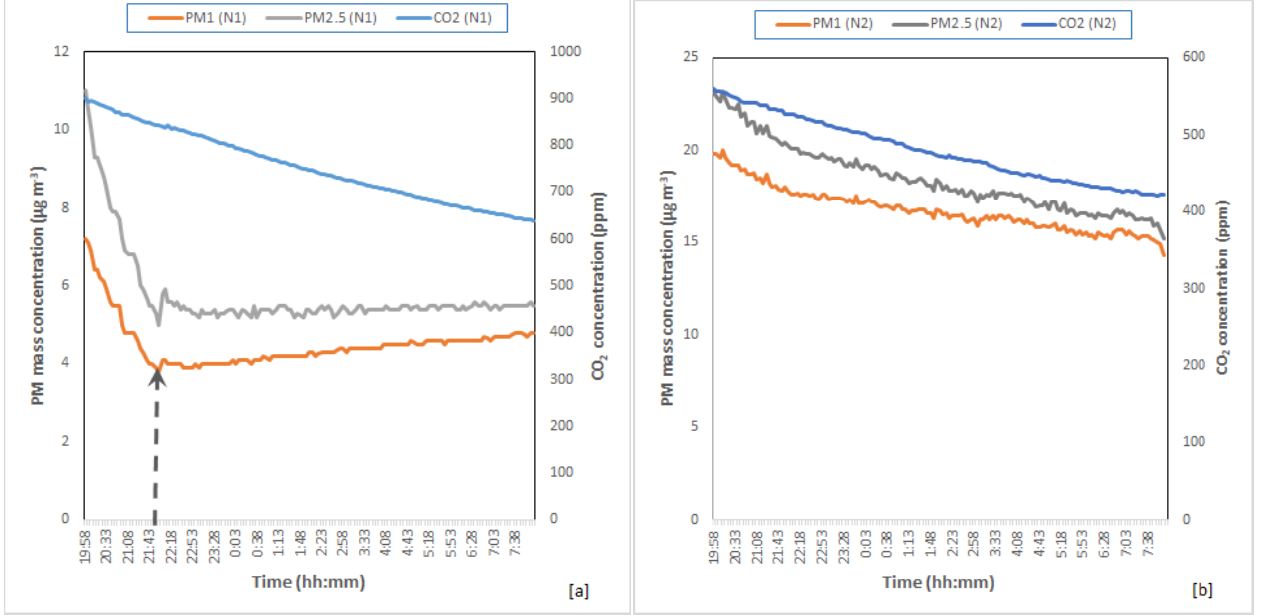
Figure 4. Campaign 3, Class: Comparison of PM mass concentrations during two nights, ( a ) with the air purifier in operation (until 21:43 h) and ( b ) with no air purifier. There was no heating and the windows and the door were closed. The air exchange rate (ACH) was 0.1 h −1 in both cases. Only the PM concentrations were affected by the air purifier operation. After 21:43, the researcher had to stop the purifier. The larger particles, above 2.5 μm, decayed clearly until the next morning (not presented in Figure 4a). The concentrations of PM 1 and PM 2.5 slightly increased after the air purifier was turned off — a battle between coagulation and decay. CO and CO 2 were not affected; they decayed as they did every night. The TVOC retained an almost constant concentration on all nights.